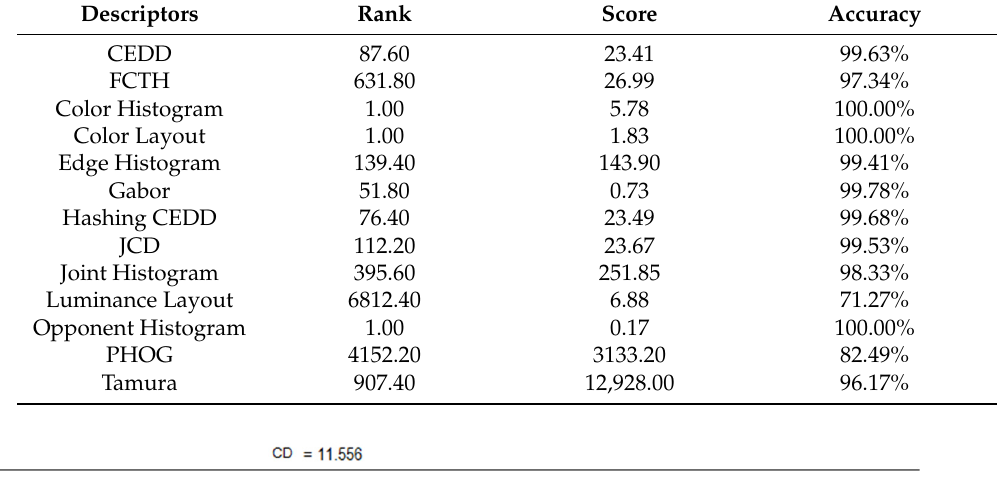
Table 4. Descriptors’ performance for retrieving random noise-affected face images.